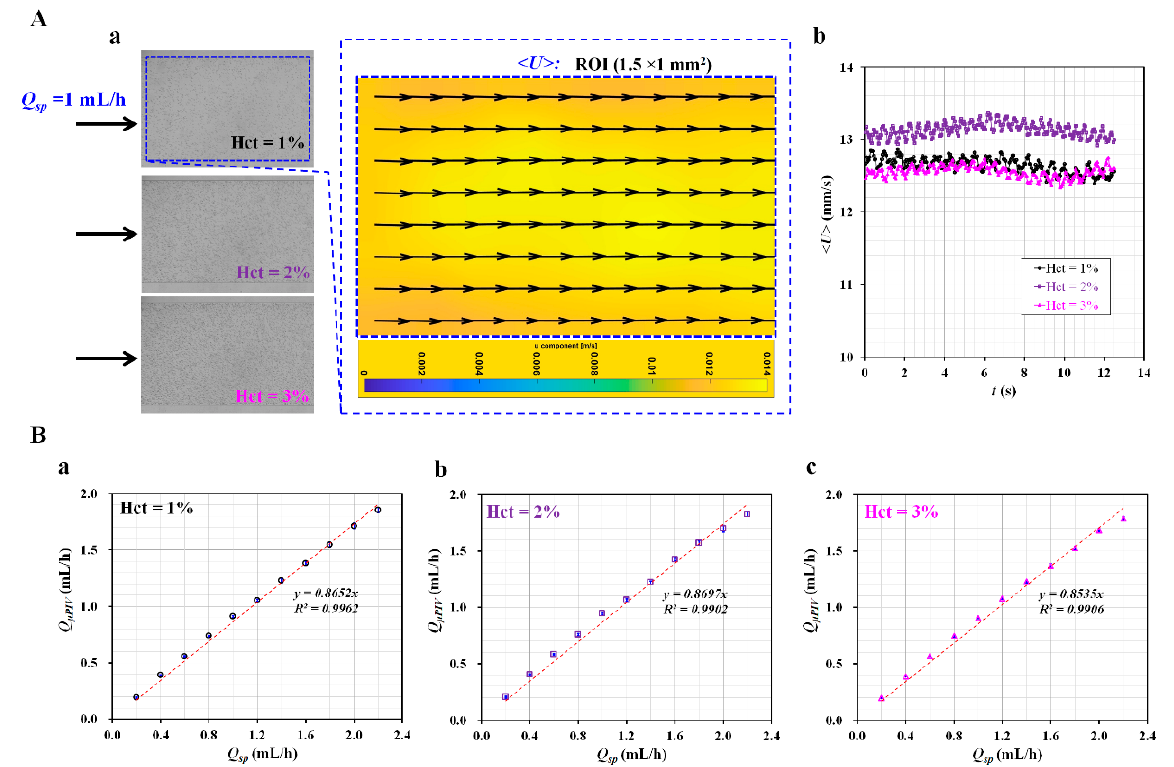
Figure 2. Validation of flow rate of reference fluid stream with micro-particle image velocimetry (PIV). ( A ) Microscopic images of reference fluid and averaged velocity (< U >) obtained with micro-PIV with respect to red blood cell (RBC) volume. ( a ) Three microscopic images with respect to RBC volume (hematocrit (Hct)). The right panel shows velocity fields of reference fluid (Hct = 1%). ( b ) Temporal variations of < U > with respect to RBC volume (Hct). ( B ) Linear relation between flow rate of reference fluid obtained with micro-PIV and flow rate set by syringe pump with respect to RBC volume (Hct) (( a ) Hct = 1%, ( b ) Hct = 2%, and ( c ) Hct = 3%). The corresponding linear slope for each RBC volume faction was obtained as 0.8652 for Hct = 1%, 0.8697 for Hct = 2%, and 0.8535 for Hct = 3%. The reference fluid flowed from the left to the right side of the RC. The right panel shows the velocity field of the reference fluid for the RBC volume fraction (Hct = 1%). The velocity fields show uniform distributions within the specific ROI (1.5 × 1 mm 2 ) of the RC.